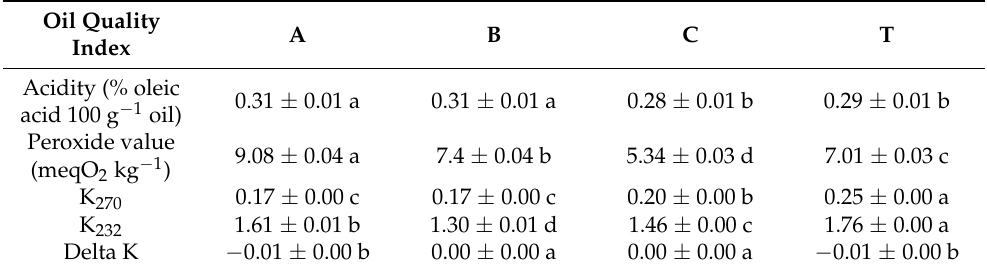
Table 3. Quality indices of analyzed oils treated with three biostimulants: A (tropical plants extract), B (glycine betaine), and T ( Trichoderma ) all compared with C (control).